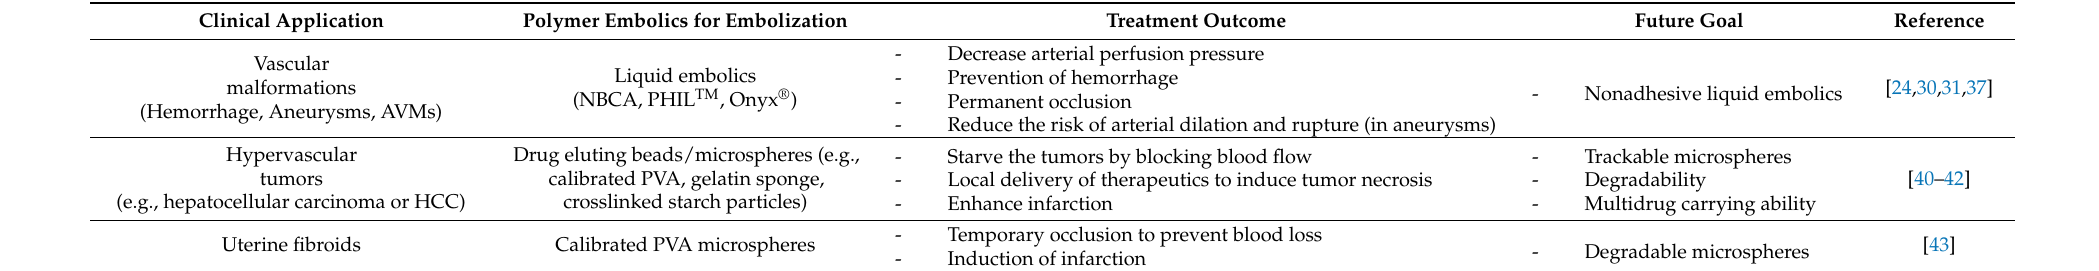
Table 1. Clinical applications of endovascular embolization using polymer